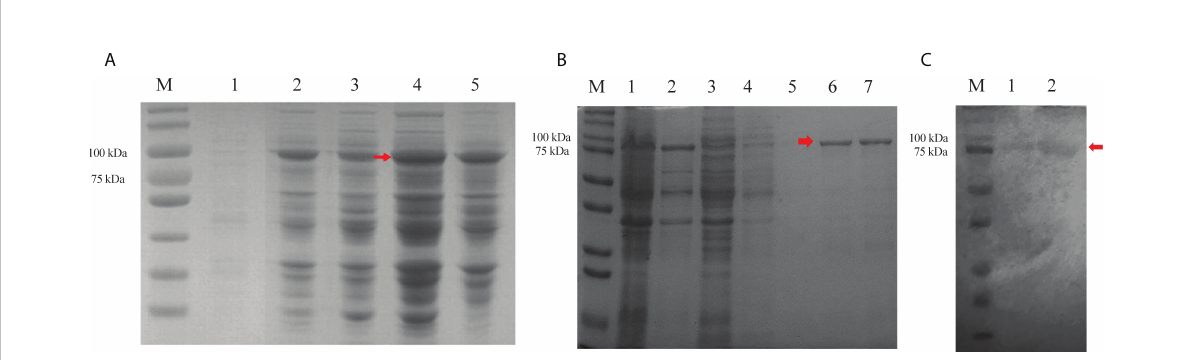
FIGURE 1 Expression and puri fi cation of recombinant Cry7Ab4 toxic core. (A) Expression of recombinant Cry7Ab4 toxic core in E coli analyzed by SDS- PAGE. M, marker; bacterial lysates without IPTG (lane 1) and with 0.5-mM IPTG induction at 25°C (lane 2) and 37°C (lane 3), respectively; supernatant (lane 4) and pellet (lane 5) from bacterial lysates with 0.5-mM IPTG induction at 25°C. (B) Puri fi cation of Cry7Ab4 toxic core analyzed by SDS-PAGE. M, marker; lane 1, supernatant from bacterial cell lysates containing Cry7Ab4 toxic core; lane 2, pellet from bacterial cell lysates; lane 3, fl ow-through from the Ni-NTA column; lanes 4 and 5, fi rst and second imidazole (20 mM) washing fractions, respectively; lanes 6 and 7, fi rst and second imidazole (200 mM) elution fractions, respectively. (C) Western blot analysis of puri fi ed recombinant Cry7Ab4 toxic core. Puri fi ed recombinant His-tagged Cry7Ab4 toxic core was separated by SDS-PAGE, transferred to nitrocellulose membrane, and detected by mouse anti- His polyclonal antibody. M, marker; lanes 1 and 2, puri fi ed recombinant Cry7Ab4 toxic core. The red arrows indicate Cry7Ab4 toxin.